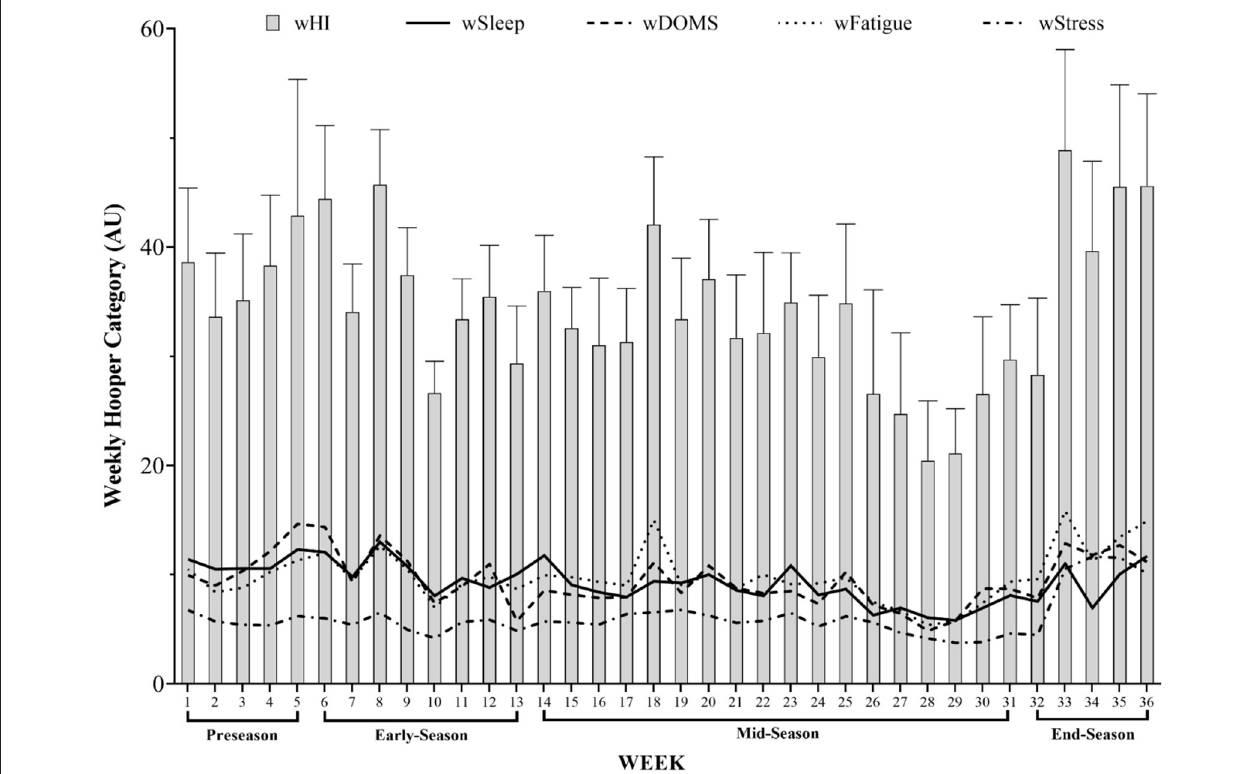
FIGURE 1 | Description of weekly patterns for well-being variables across the season. wSleep, weekly sleep; wDOMS, weekly muscle soreness; wFatigue, weekly fatigue; wStress, weekly stress; wHQ, weekly Hooper questionnaire.